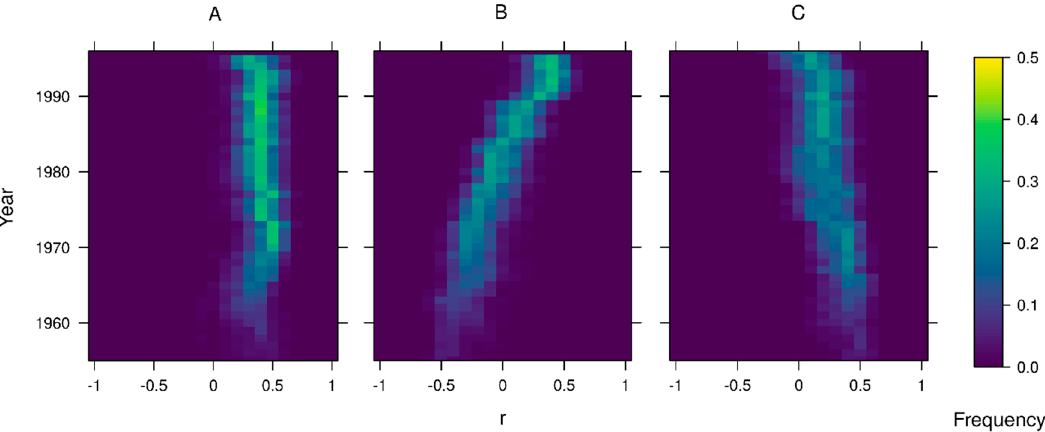
Figure 2. Frequency distributions (3D histograms) of individual tree correlation values with climate variables over time (30 year moving window). ( A ) correlation of individual TRI with April SPEI9; ( B ) correlations with June temperature; ( C ) correlations with previous year August SPEI6.